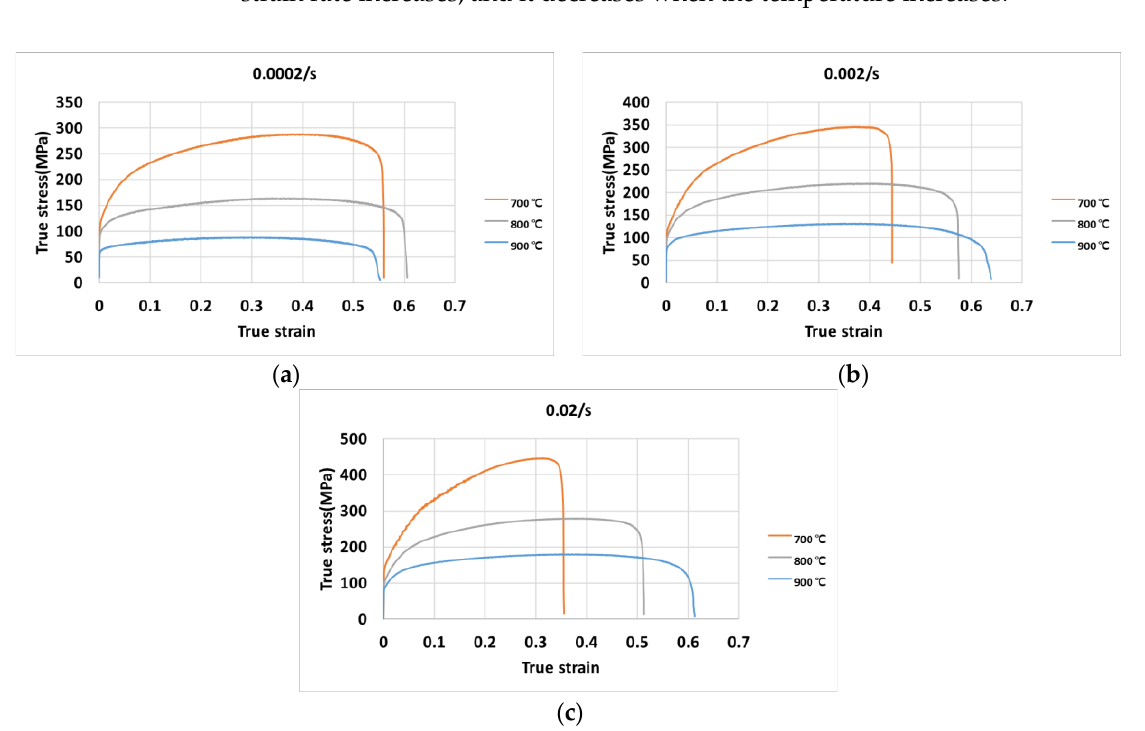
Figure 5. Stress – strain curves at the strain rates of ( a ) 0.0002/s, ( b ) 0.002/s, and ( c ) 0.02/s. Figure 5. Stress–strain curves at the strain rates of ( a ) 0.0002/s, ( b ) 0.002/s, and ( c ) The final form of the equation describing the flow stress with the Zener-Hollomon parameter is obtained using Equations (1) and (2) after calculating all the material con- stants. The equation of stress is as shown below in Equation (13).